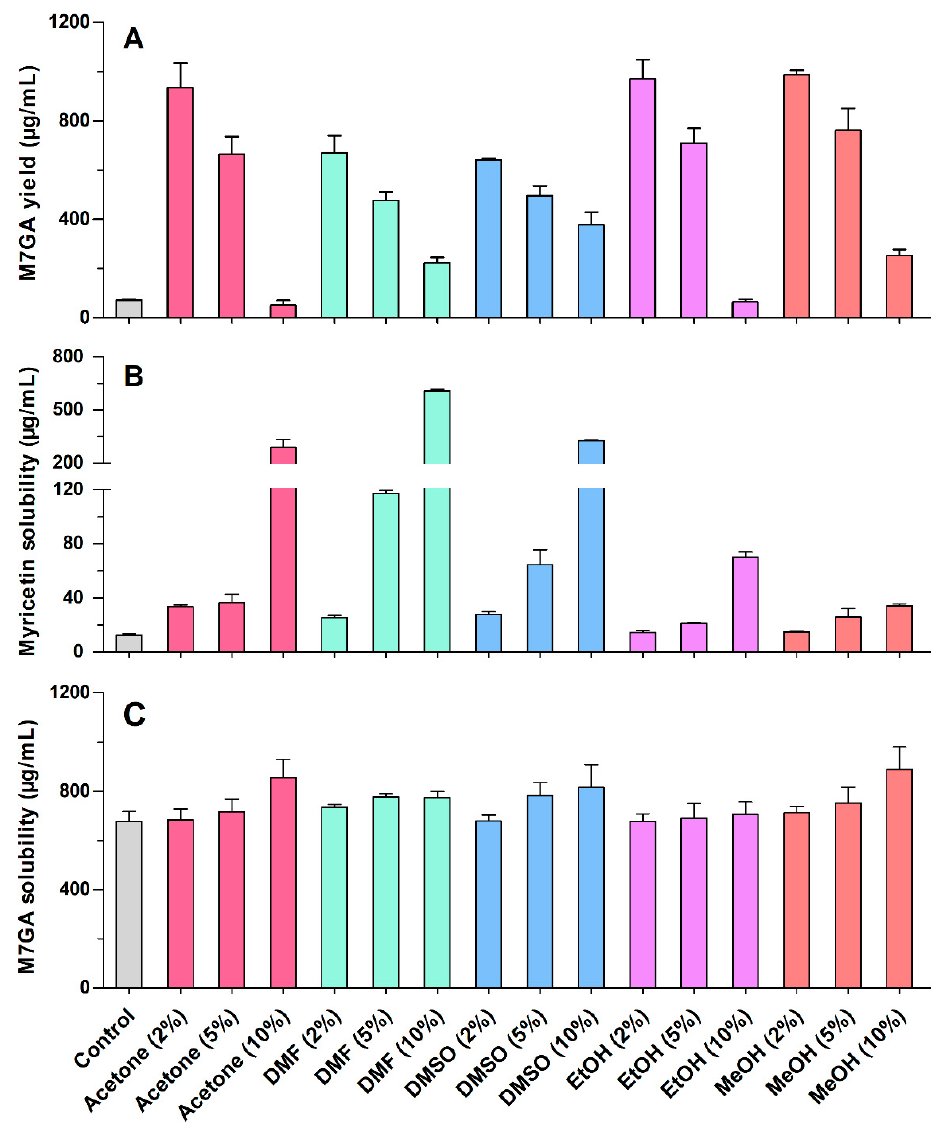
Figure 1. Effects of different organic solvents on the whole-cell reaction and the substrate and product solubilities. ( A ) Bioconversion of myricetin to myricetin-7- O -glucuronide (M7GA) catalyzed by E. coli BPGUT cells in the presence of organic solvents; ( B ) The solubility of myricetin and ( C ) the solubility of M7GA obtained in the modified M9 medium containing different concentrations of organic solvents.